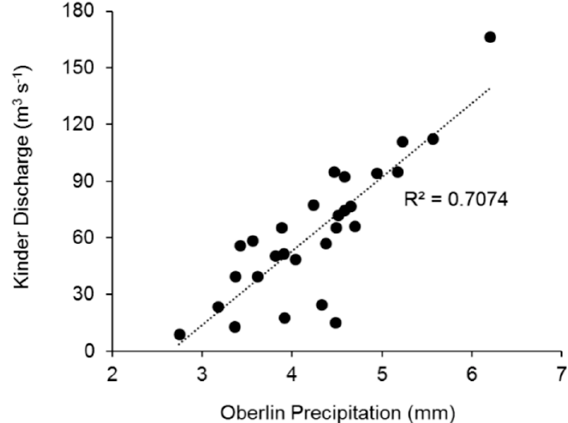
Figure A5. The relationship between discharge at Kinder (United States Geological Survey (USGS) station number: 08015500) and precipitation at Oberlin (National Oceanic and Atmospheric Administration (NOAA) station number: USC00166938). Each dot in the figure represent a pair of mean discharge and precipitation during a certain year from 1990 to 2017.